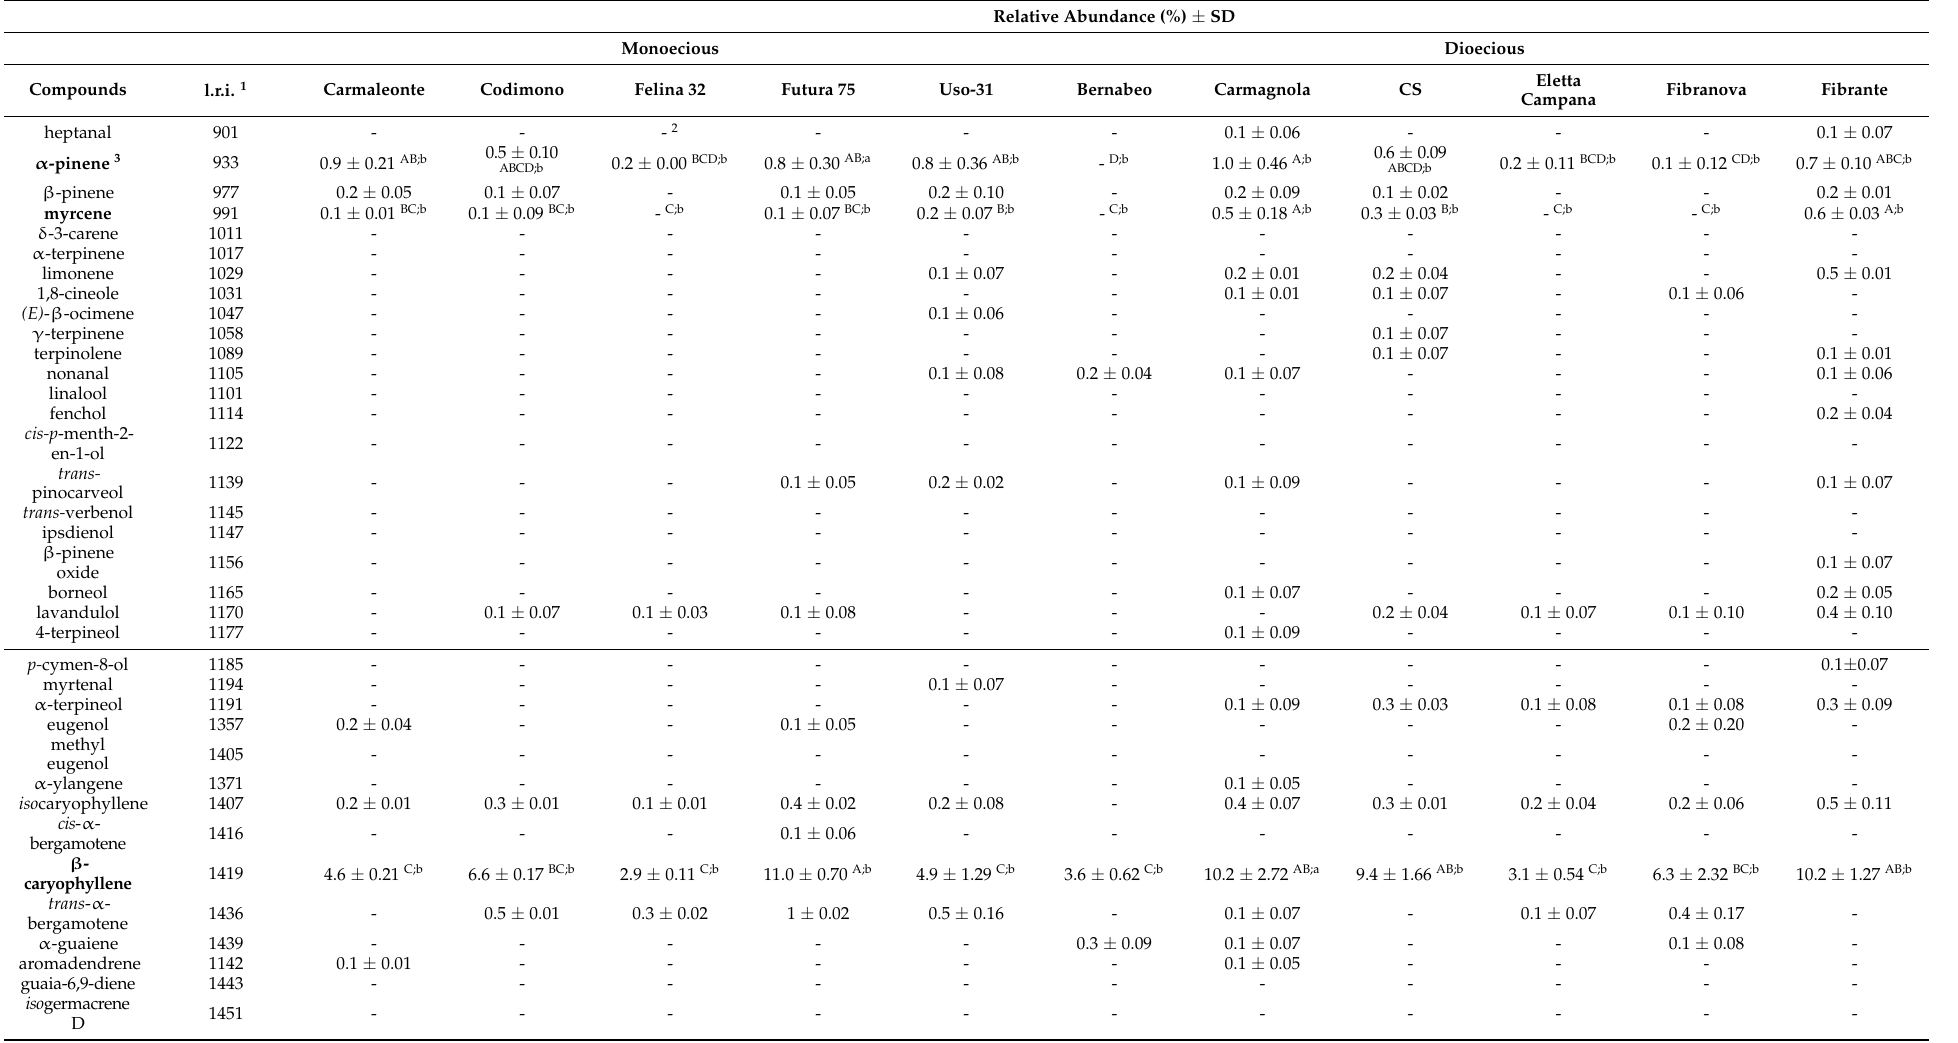
Table 2. Complete composition and extraction yield (% w/w dry weight) of the essential oil obtained from the dried inflorescences and floral bracts of 2019 hemp